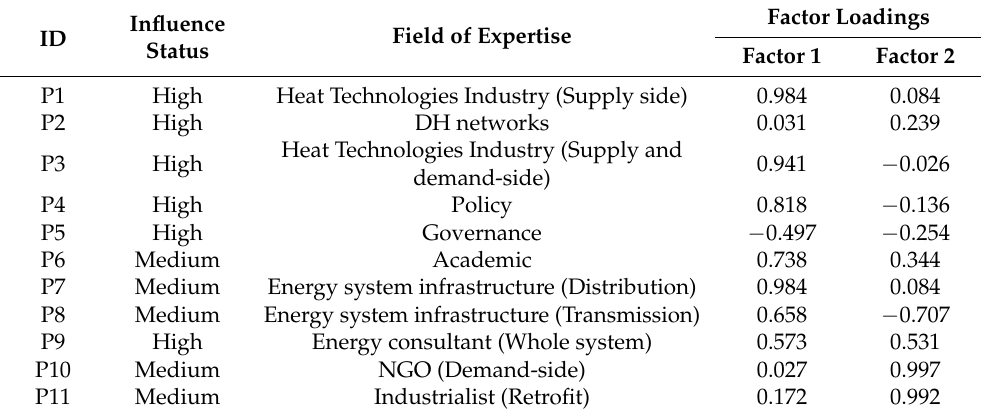
Table 1. Factor loadings of experts for top two components.